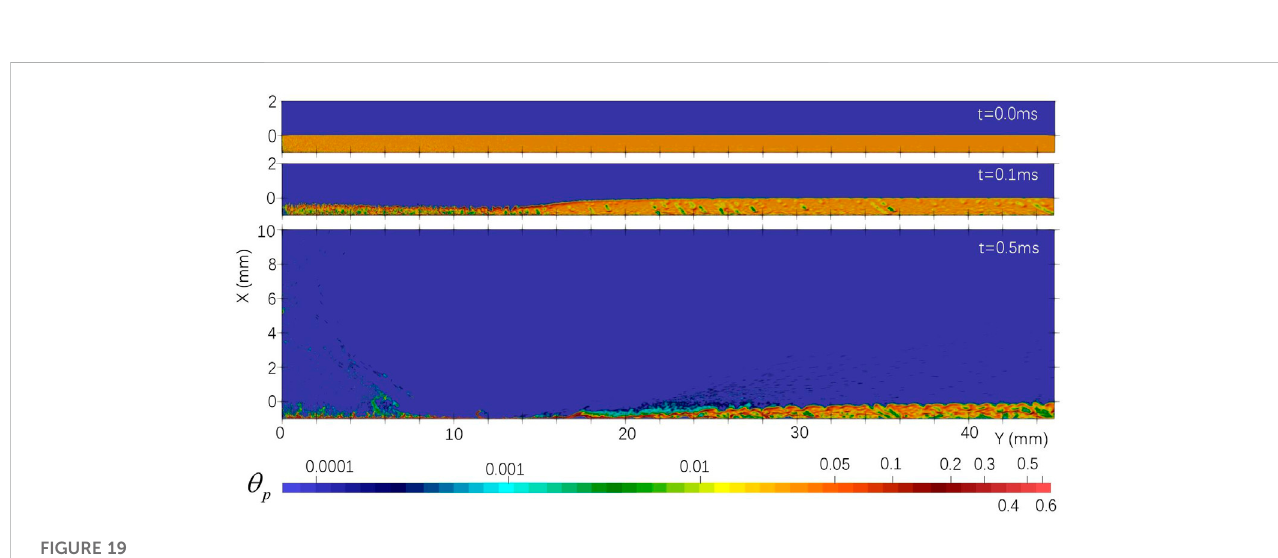
FIGURE 19 Solid phase volume fraction in the MPPIC